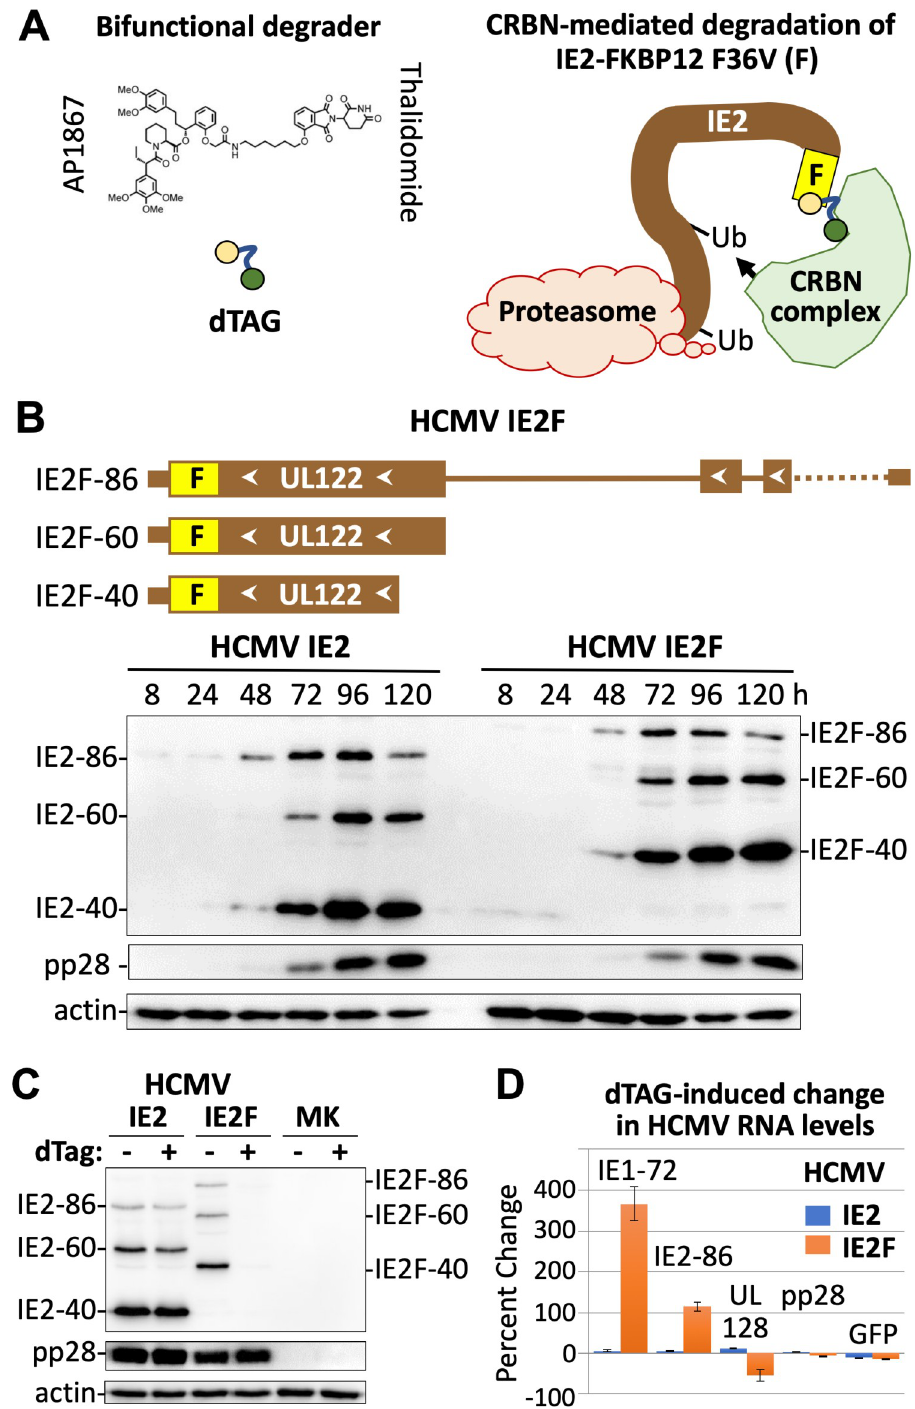
Fig 1. Targeted degradation of IE2 in late infection–proof of principle. (A) Schematic depiction of the targeted degradation strategy using dTag to target an IE2 protein tagged with FKBP12 F36V (F) for degradation by the host cereblon (CRBN)-ubiquitination-proteasome pathway. ( B) FKBP12 F36V was fused in-frame to carboxyl ends of IE2-86, IE2-60, and IE2-40 in the HCMV Towne recombinant, named HCMV IE2F. Western blot shows amount of tagged IE2-86F, IE2-60F, and IE2-40F proteins expressed in HCMV IE2F-infected HFF over time, compared to untagged IE2 expressed from HCMV IE2 at multiplicity of infection (MOI) of 1 infectious unit per cell. ( C) Western blot shows change in IE2F levels at 96 h pi resulting from 200 nM dTag (vs. vehicle) treatment from 90–96 h pi, as compared to